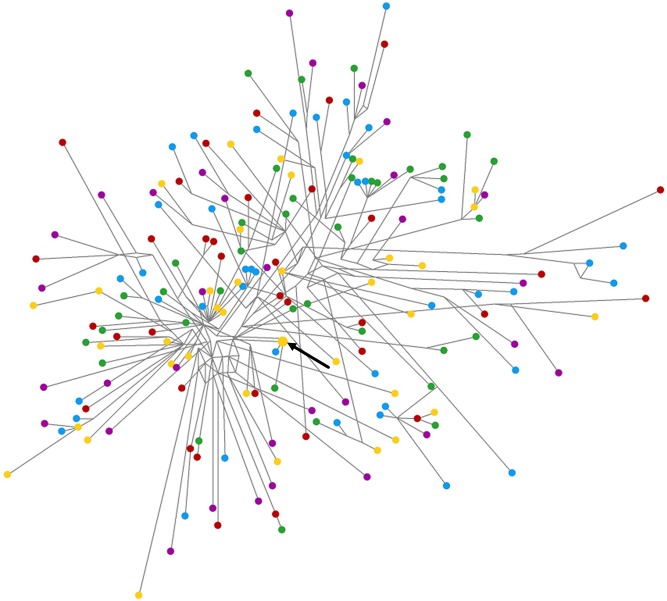
Median-joining network of mtDNA in M. neritoides.Branch lengths are proportional to the numbers of mutational steps separating haplotypes. The size of circles is proportional to the number of individuals per haplotype and the sole haplotype shared by two individuals is marked by an arrow. Haplotype origins: Flores island—green; Faial island—blue; Pico island—yellow; São Miguel island—red; Santa Maria island—purple.